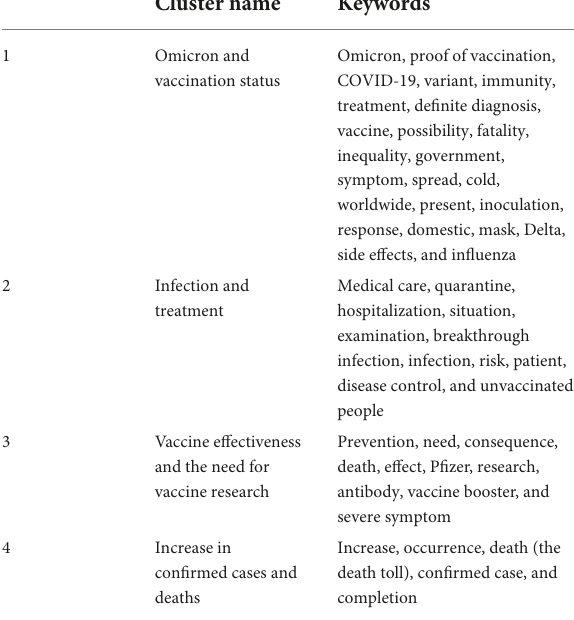
TABLE 3 Keyword factor types related to Omicron and vaccine based on CONCOR